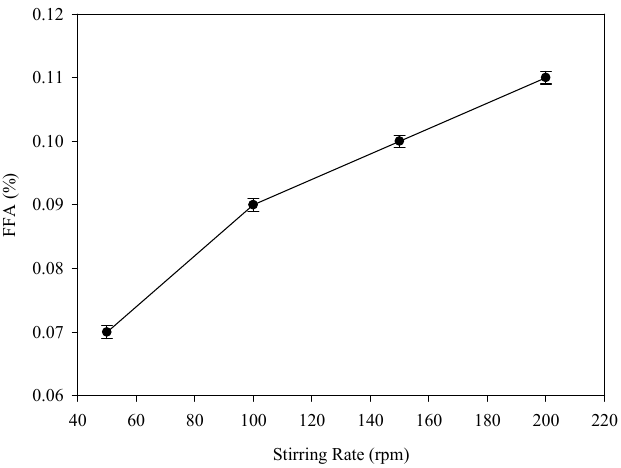
Figure 7. FFA (%) content in the recovered used vegetable oil at different stirring rates.